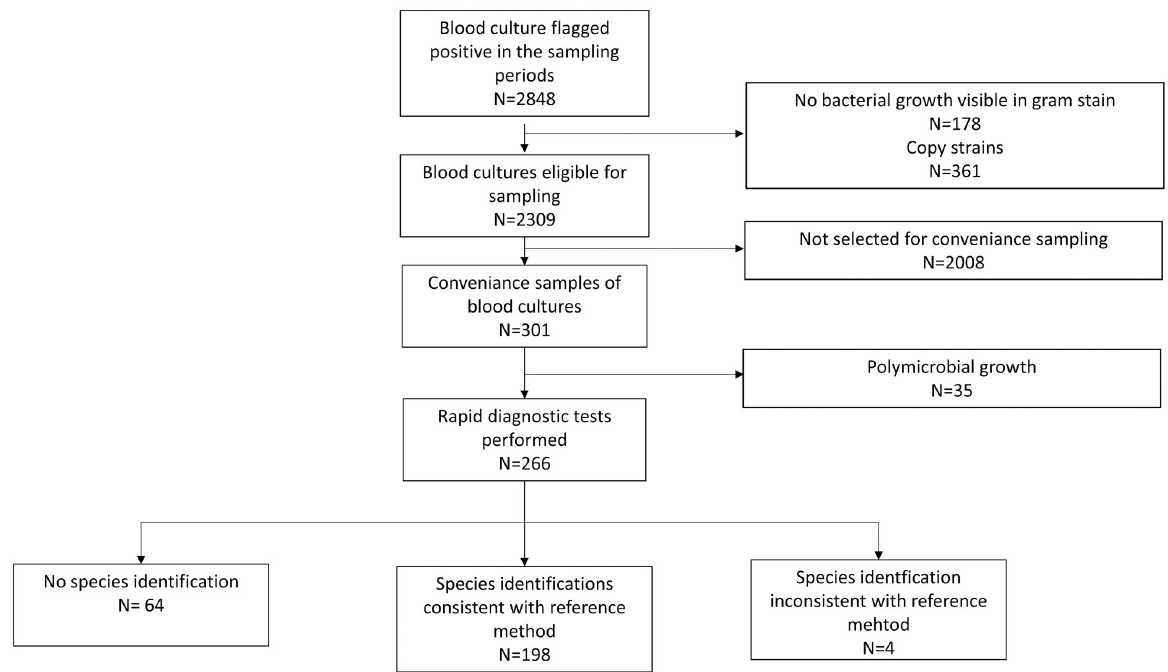
Fig 1. Flow diagram of the clinical blood culture samples included in the study and results of the fast protocol compared to the standard of care according to the STARD criteria [23].